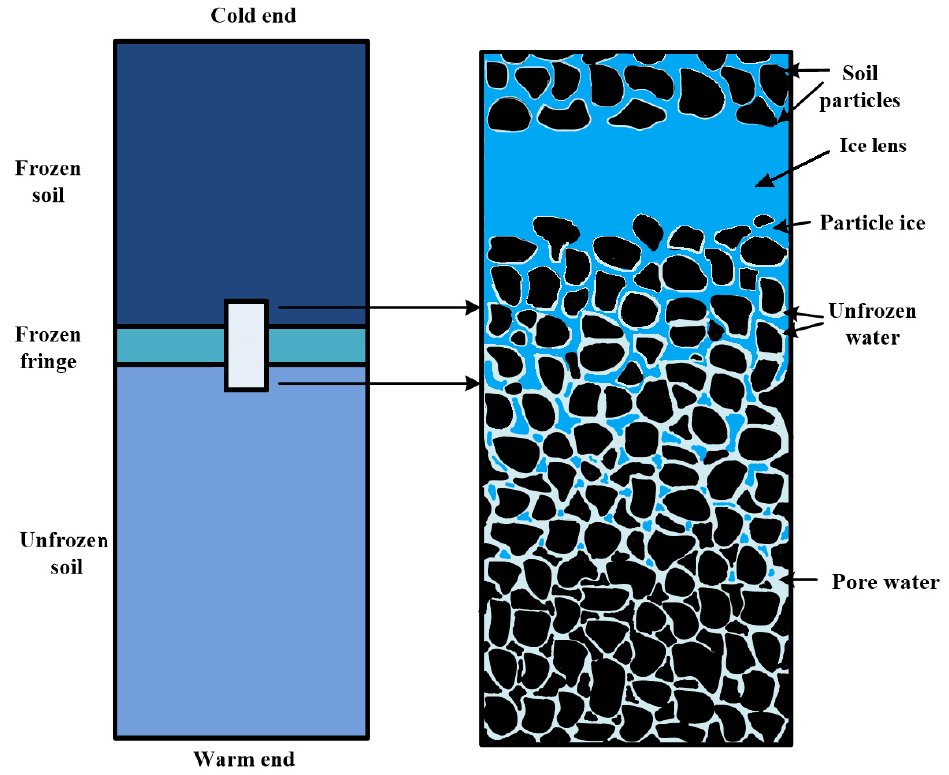
Figure 2. Microscopic schematic of soil freezing.